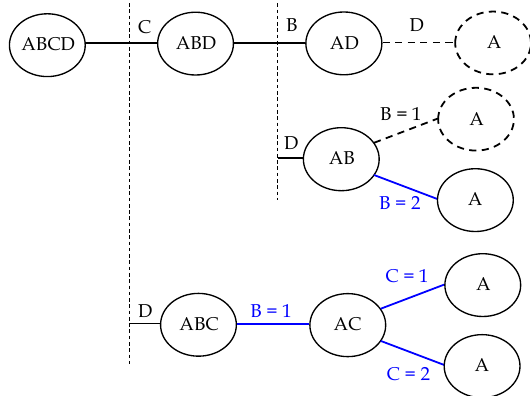
Figure A24. Tree graph for the analysis of the effect of factor A on the convergence performance. Dashed nodes and arcs correspond to rejected conclusions due to multimodal population. Arcs in blue denote decisions on the value of factors based on forced